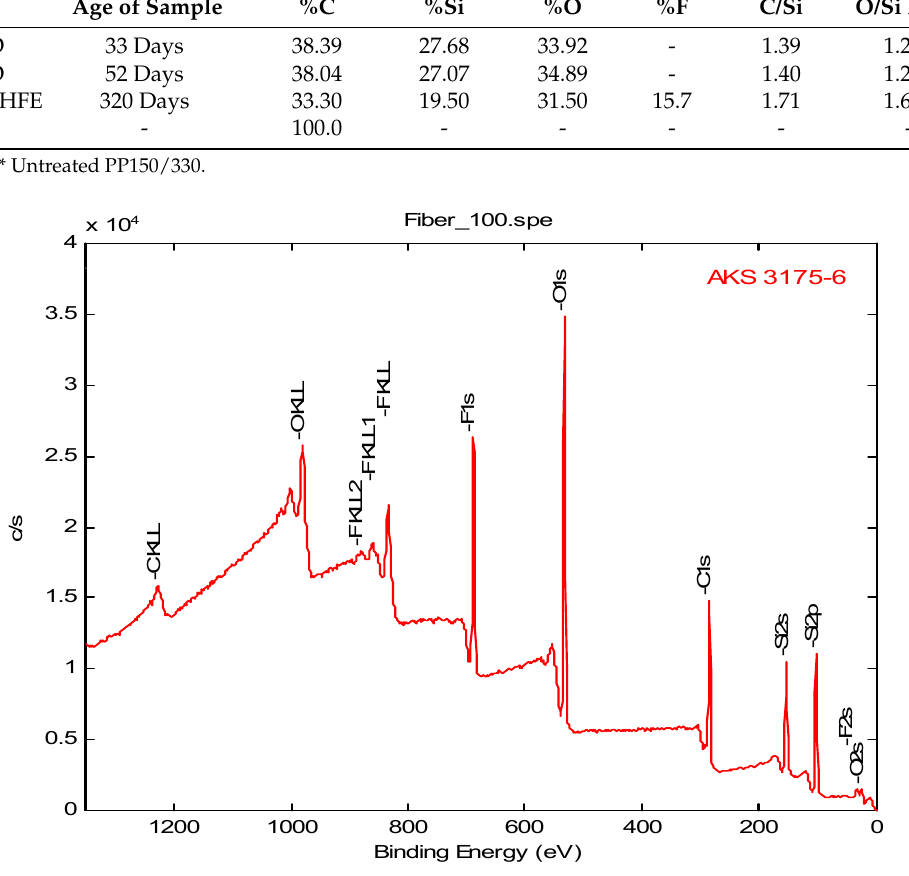
Figure 7. XPS spectrum of the F/Si plasma polymer coated PP150/330 membrane.